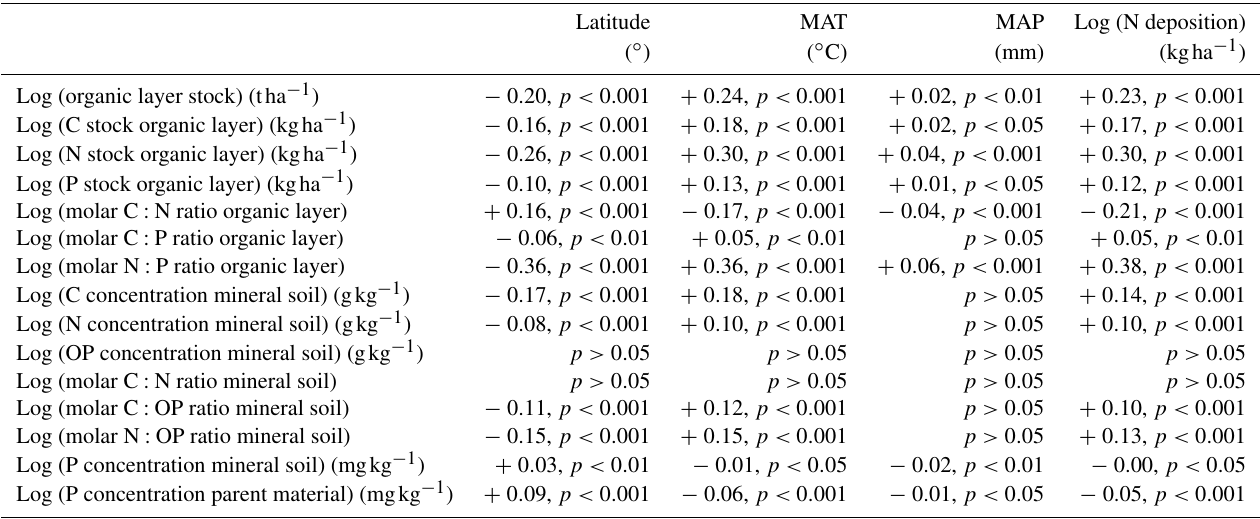
Table 1. Results of the regression analyses (adjusted R 2 , p value) for the organic layer, mineral soil (0–10cm), and parent material in 309 Swedish forest soils ( n = 309). The signs + and − indicate positive and negative regressions, respectively. Latitude MAT MAP Log (N